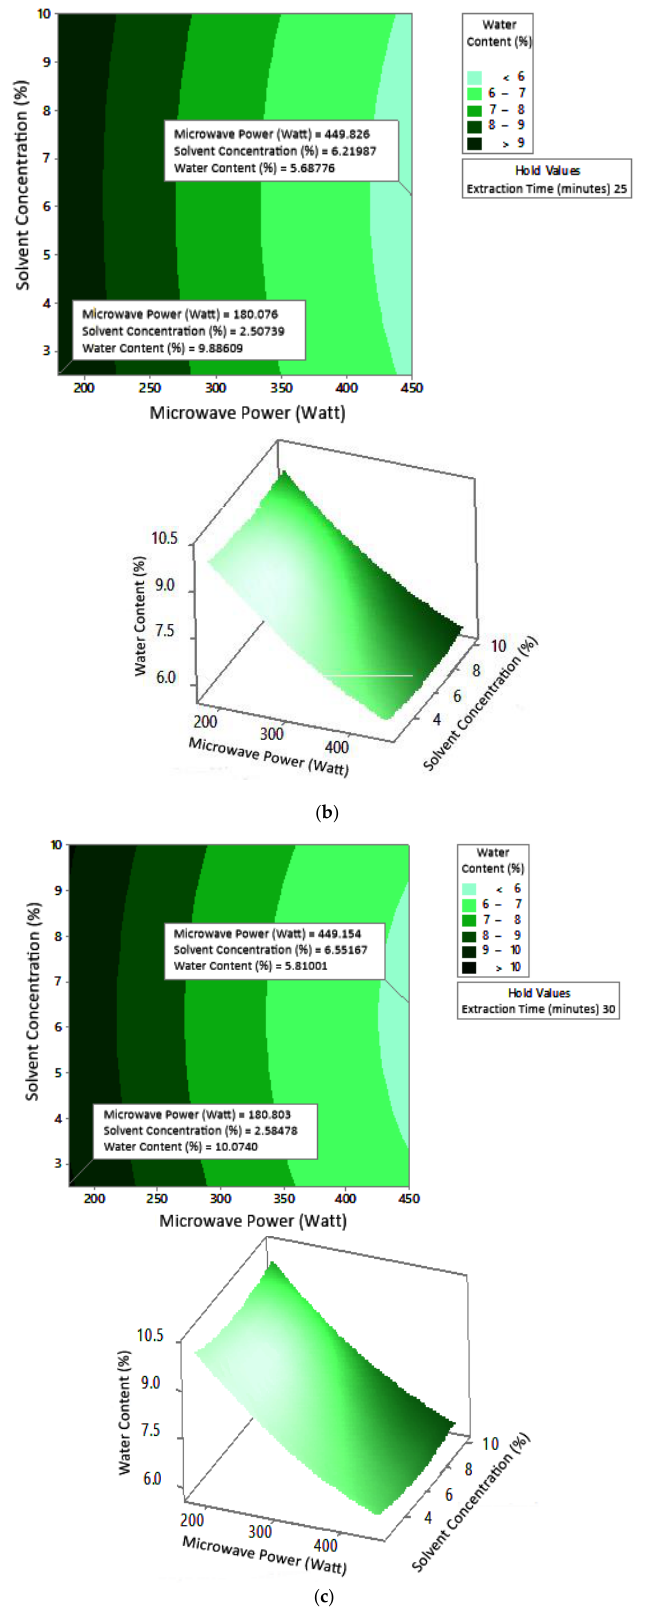
Figure 10. Effect of microwave power and solvent concentration on water content at extraction times: ( a ) 20 min, ( b ) 25 min, and ( c ) 30